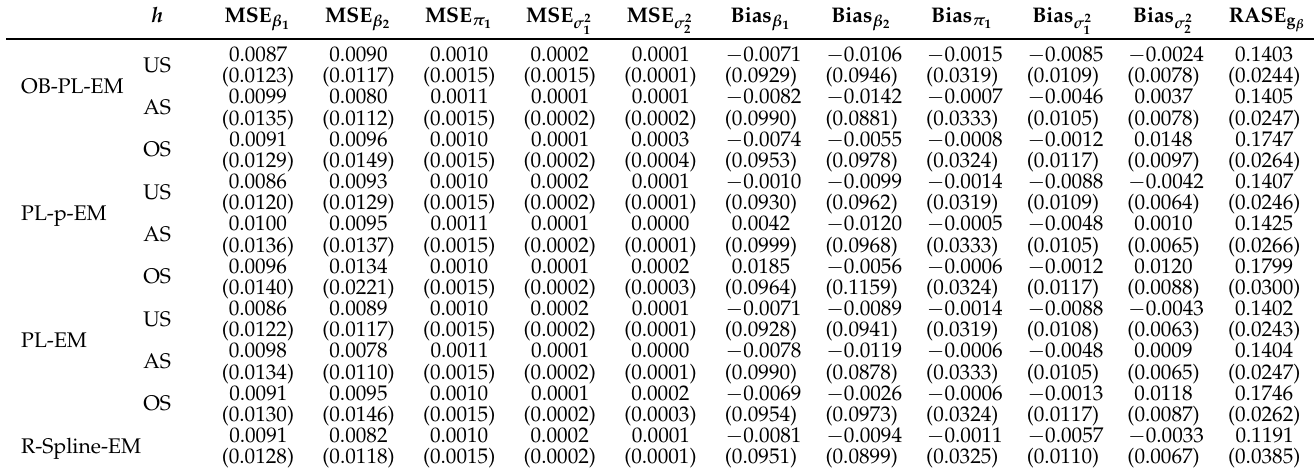
Table 2. Averages (and standard deviations) of the performance measures for n = 200.